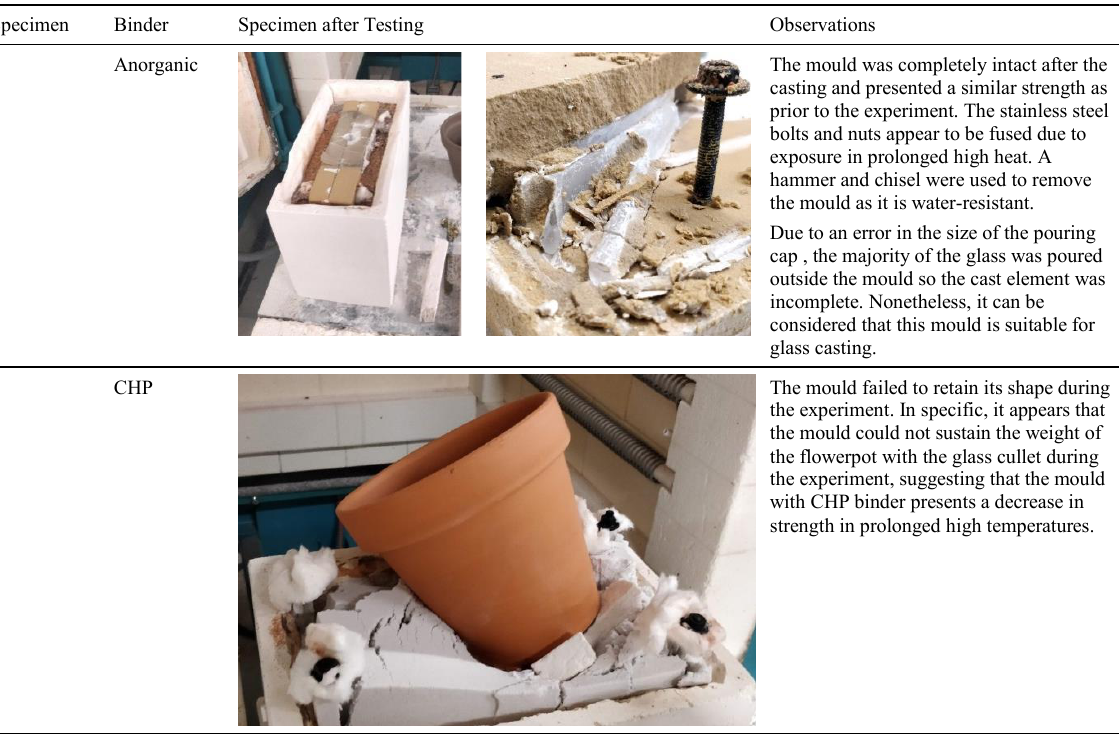
Table 6: Summary of results of Test Series